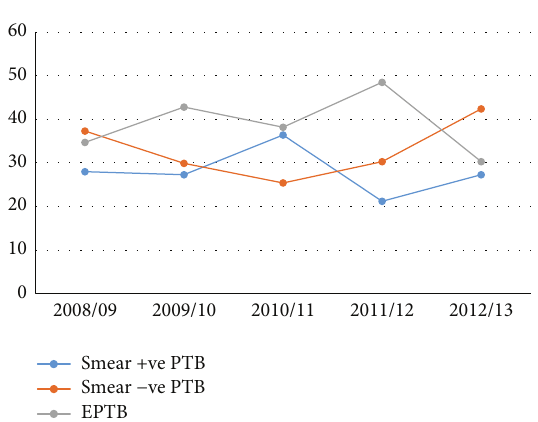
Figure 1: Trends of types of TB over the course of five years at Debre Tabor Health Center,